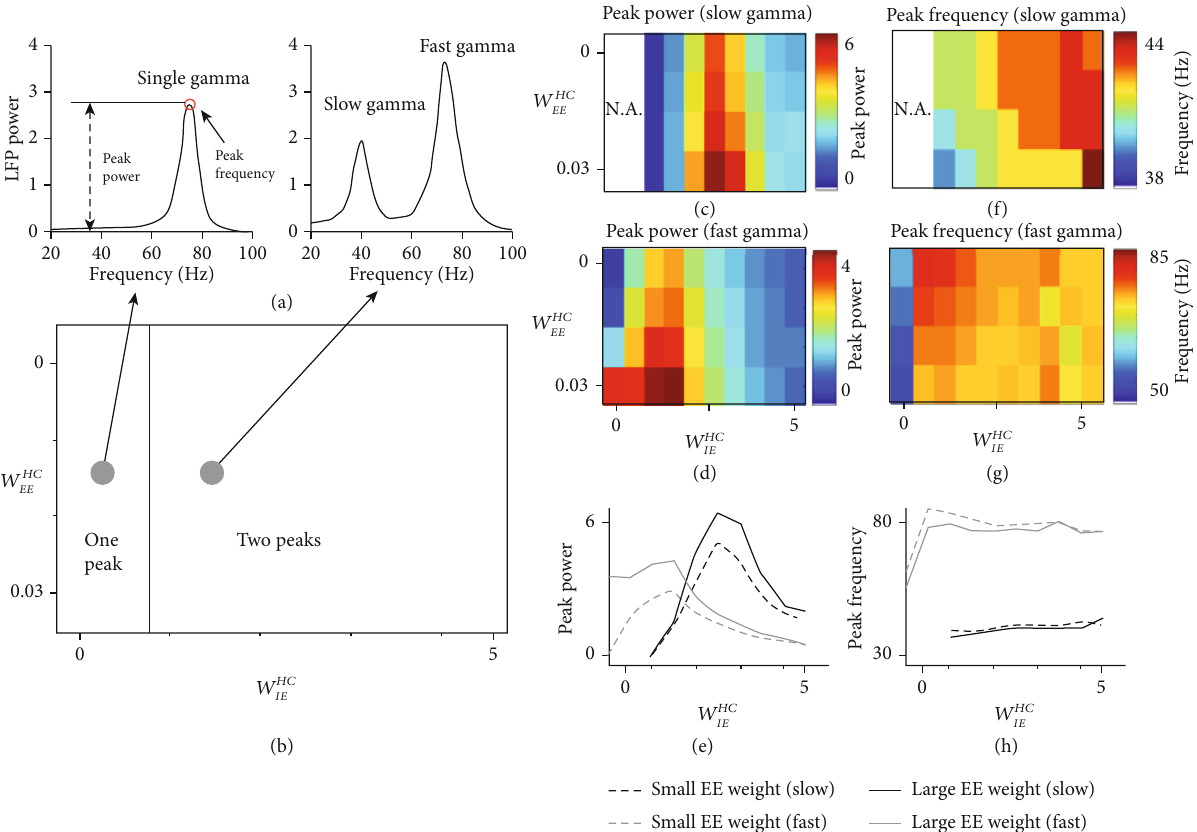
Figure 3: Phase diagram for the number of gamma oscillations and the modulation of existing gamma in HC network without FB. (a) shows the power spectrums of the LFPs from two example networks. Although both of the two networks have local RC and HC, but their HC connection strengths are di ff erent. There are two distinct oscillatory states (b): (1) one gamma oscillation and (2) two gamma oscillations. These oscillatory states are dependent on parameters ( W HC EE and W HC IE ) for HC connection strengths of the network in (b). The power of slow and fast gamma for di ff erent connection strength is shown in (c) and (d), respectively. (e) shows how the peak power changes with connection weight W HC IE corresponding to color plots (c) and (d). The black lines denote the cases of slow gamma (dashed black line for = 0 , and solid black line for W HC = 0 : 03 ), and grey lines are for fast gamma (dashed grey line is for W HC W HC EE EE for W HC EE = 0 : 03 ). The peak frequency of slow and fast gamma for di ff erent connection strength is shown in (f) and (g), respectively. (h) shows how peak frequency changes of connection weight W HC IE corresponding to the color plot in (c) and (d). The black line denotes the case of slow gamma (dashed line for W HC EE = 0 , and solid line for W HC EE = 0 : 03 ) and grey line is for that of fast gamma (dashed line for = 0 , and solid line for W HC = 0 : 03 W HC EE EE